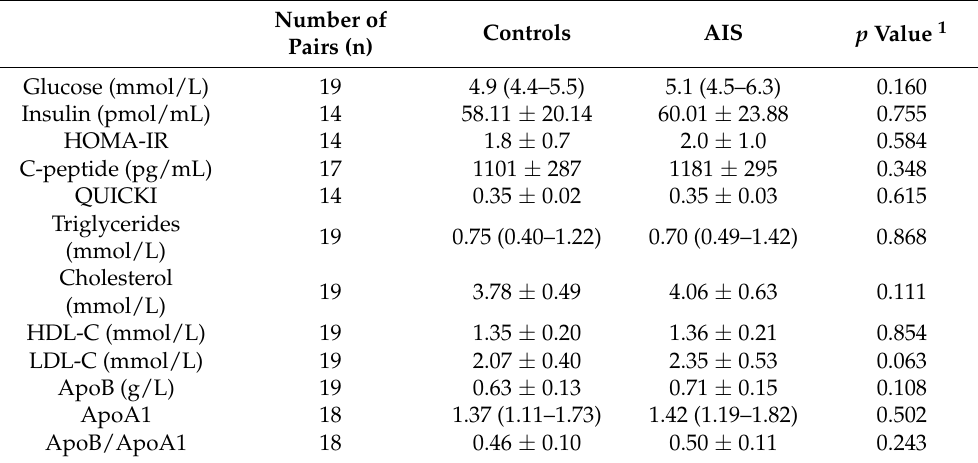
Table 4. Biochemical characteristics of control and AIS participants.